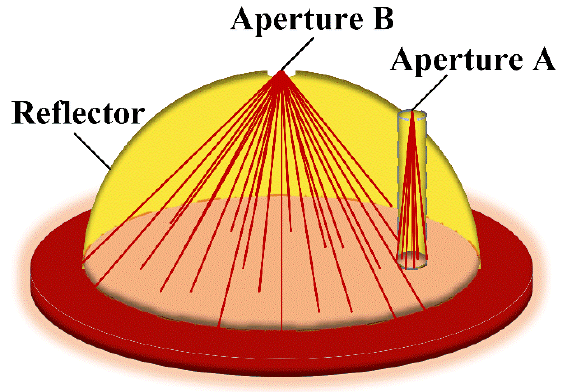
Figure 1. Structure diagram of reflector with two apertures.